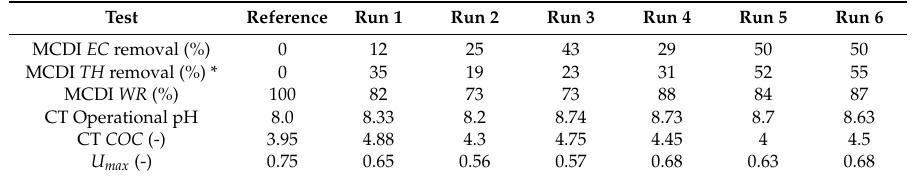
Table 6. MCDI removal ratios and operational parameters for Merades cooling tower at test conditions. Test Reference Run 1 Run 2